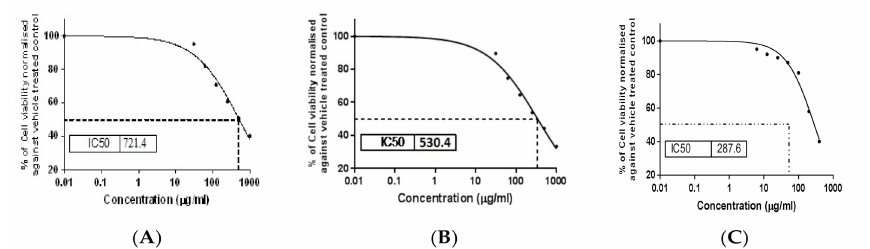
Figure 4. Evaluation of cell viability percentage of Healthy human hepatic cells(THLE2) posttreatment: ( A ) S. satureioides HD oil and ( B ) nanoemulsions of S. satureioides oil compared with reference drug ( C ) 5-flurouracil using MTT